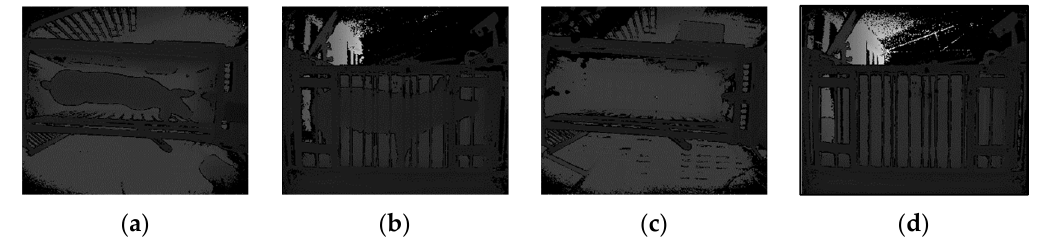
Figure 2. Original depth images: ( a ) Top-view pig depth image; ( b ) side-view pig depth image; ( c ) Top-view depth image of the individual information collection channel acquired with no pig in the channel; ( d ) Side-view depth image of the individual information collection channel acquired with no pig in the channel.